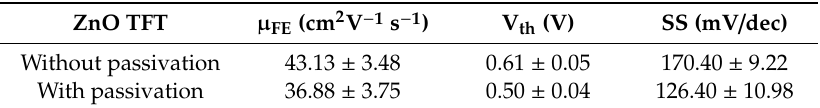
Figure 5. Statistical analysis of the electrical performances of the ZnO TFTs without and with Y 2 O 3 passivation. The histogram of 15 ZnO TFTs for ( a ) mobility, ( b ) V TH , and ( c ) subthreshold swing (SS), respectively. Table 2. Summary of the electrical performances of 15 ZnO TFTs fabricated by spray pyrolysis without and with Y 2 O 3